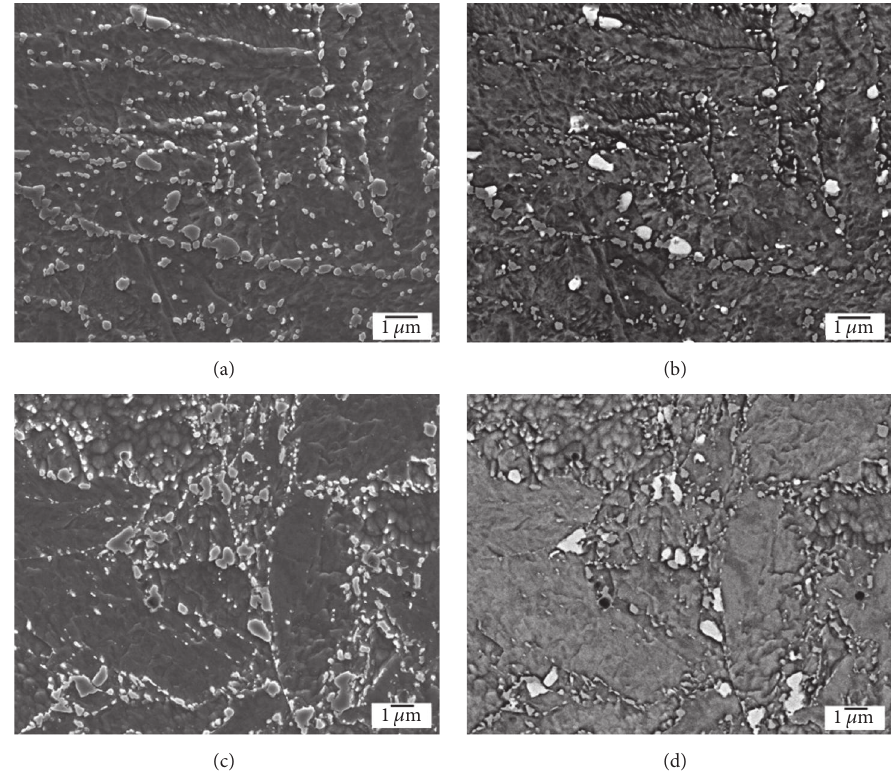
Figure 4: SEM-micrographs of thermally exposed microstructures at 625 ∘ C for 30 kh of BM (a, b) and WM (c, d) of the CB2 weldment visualized using secondary electrons (a, c) and back-scattered electrons (b, d).